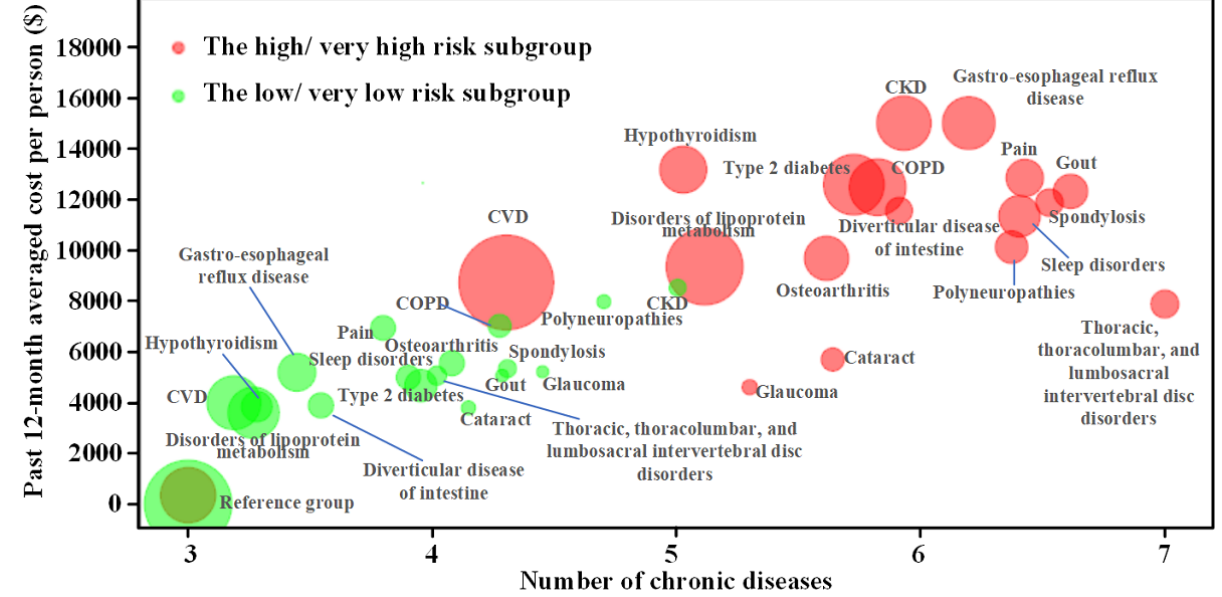
Figure 7. Patients' average clinical costs in the past 12 months with respect to the average number of chronic diseases; 17 common diseases are presented in the low- and very low–risk group (green) and the high- and very high–risk group (red). CKD: chronic kidney disease; COPD: chronic obstructive pulmonary disease; CVD: cardiovascular